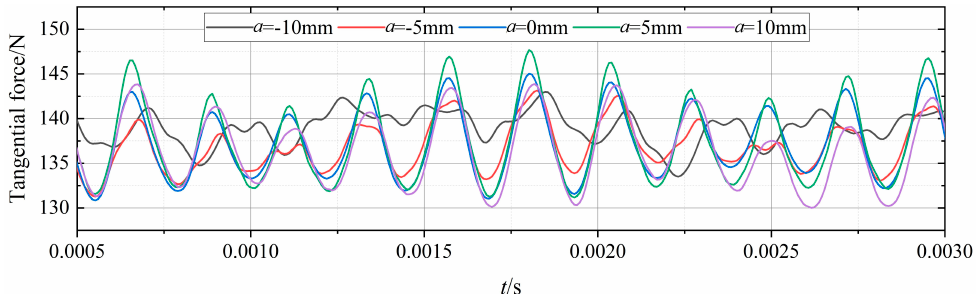
Figure 16. Tangential force–time domain distribution under near-blockage conditions.